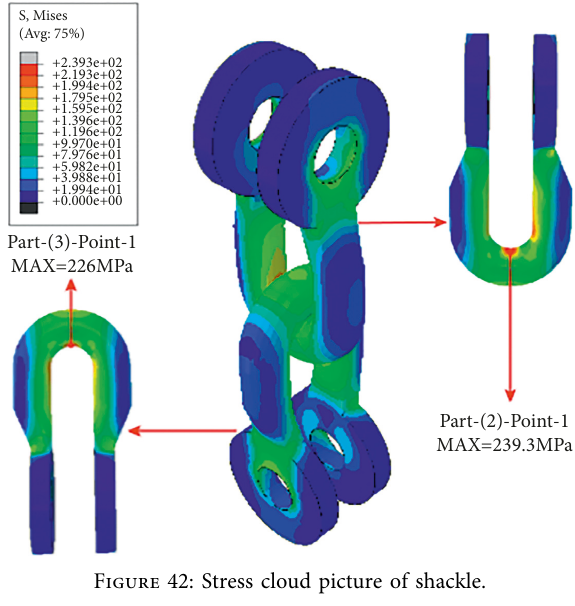
Figure 42: Stress cloud picture of shackle.